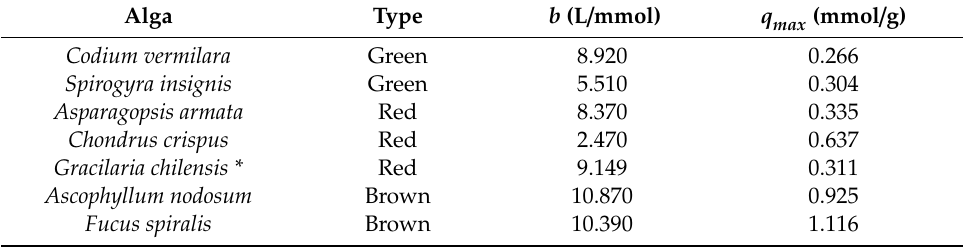
Table 5. Values of Langmuir constants for copper biosorption by di ff erent macroalgae types [26].